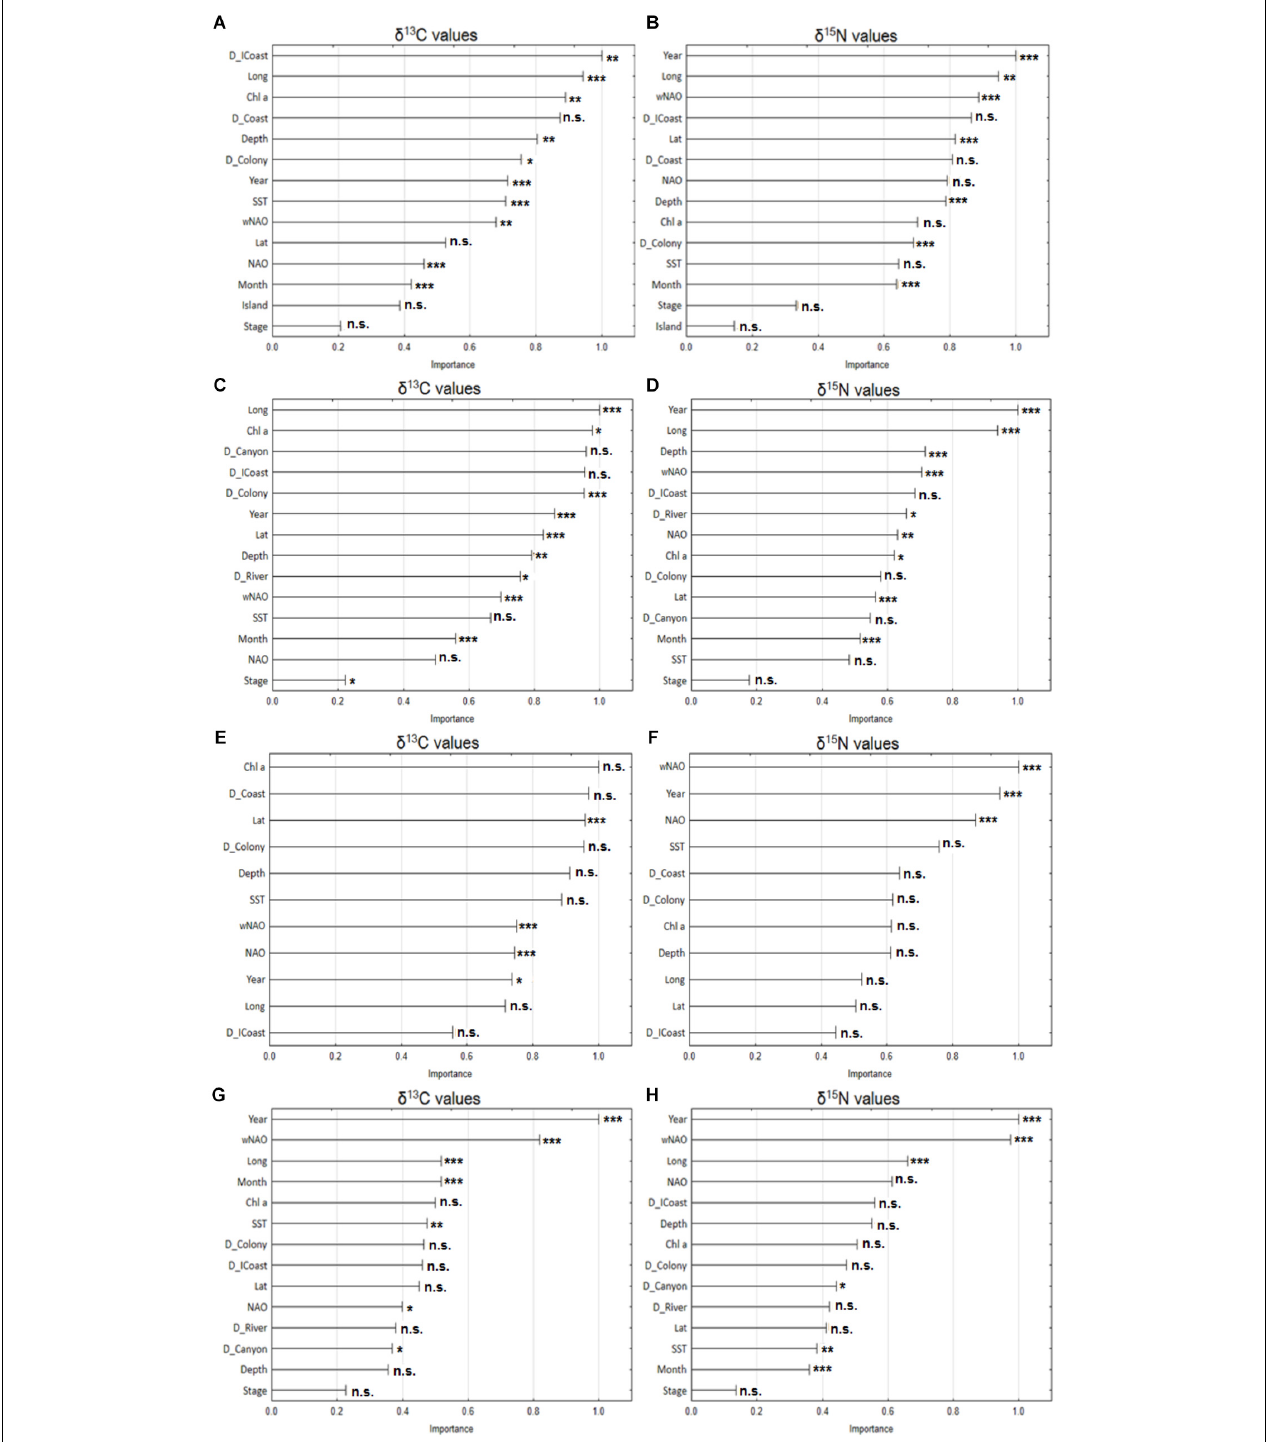
FIGURE 3 | Variable importance plot of the explanatory variables used in the random forest models for plasma δ 13 C (left panels) and δ 15 N (right panels) values from Cory’s shearwaters ( Calonectris borealis ) sampled during this study. (A,B) Correspond to the pooled data (191 individuals from Berlenga and Corvo Islands, between 2010 and 2015); (C,D) correspond to the 142 individuals from Berlenga Island between 2010 and 2015; (E,F) correspond to the 49 individuals from Corvo Island in 2010 and 2015; and (G,H) correspond to the 90 individuals from Berlenga Island that actively fed within 100 km from the colony between 2010 and 2015. Significant results resulted from mixed-effects ANOVA for the effect of explanatory variables in δ 13 C and δ 15 N values (with year, stage, month and island treated as fixed effects) are also shown ( ∗∗∗ p < 0.001; ∗∗ p < 0.01; ∗ p < 0.05; n.s. non-significant). See Table 1 for a description of each explanatory variable.